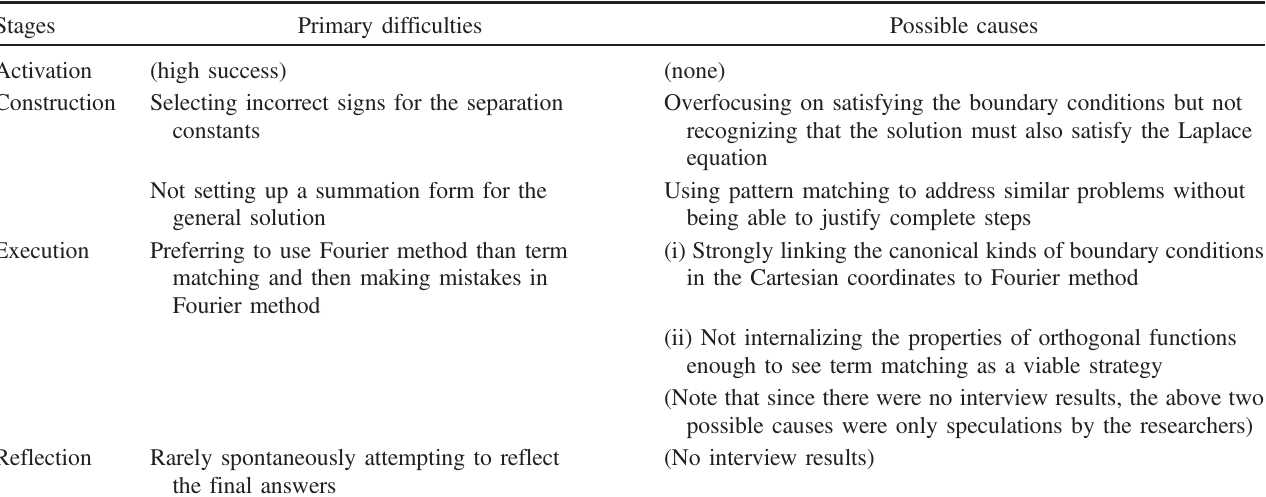
TABLE XI. Primary difficulties of students on solving the Laplace equation in Cartesian coordinates, and the possible causes to which they